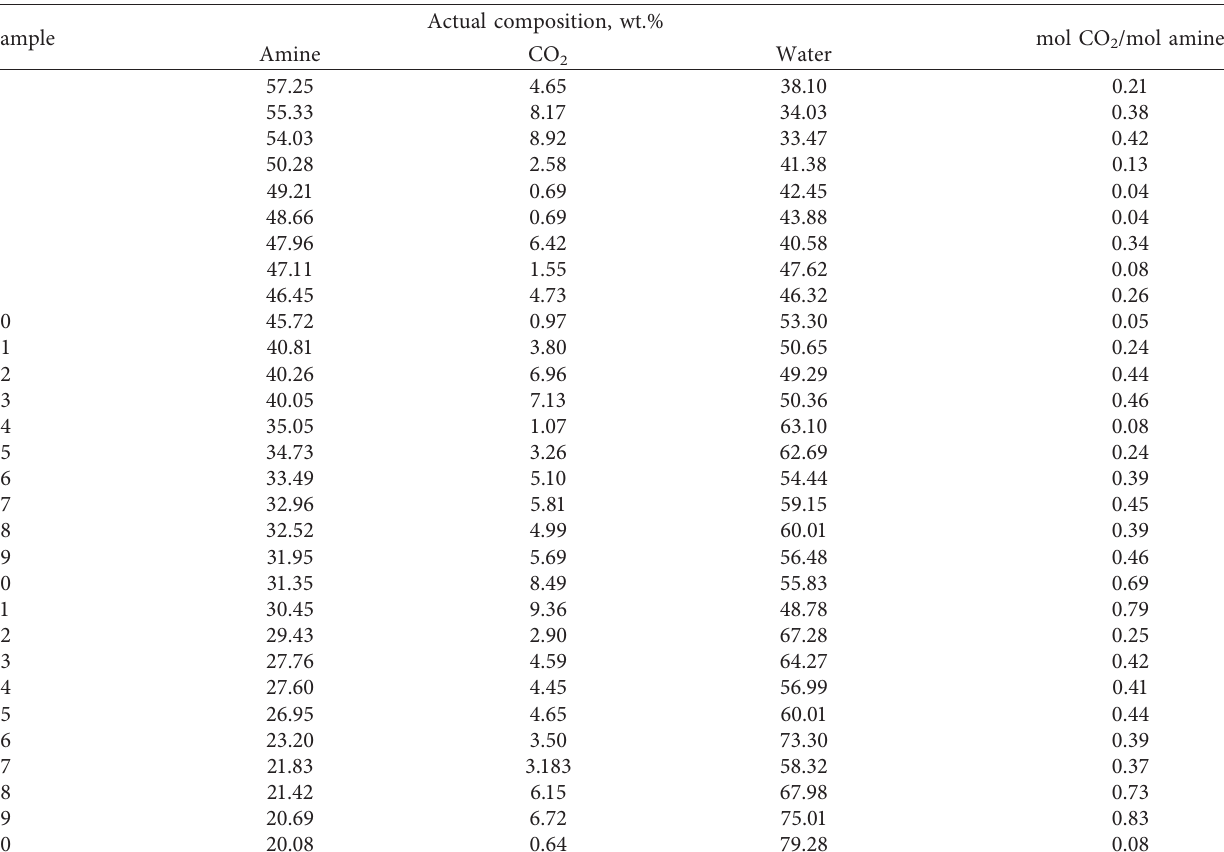
Figure 1: Absorption band in near-infrared (NIR) [14]. Table 1: Amine, CO 2 , and water content in the prepared solvent